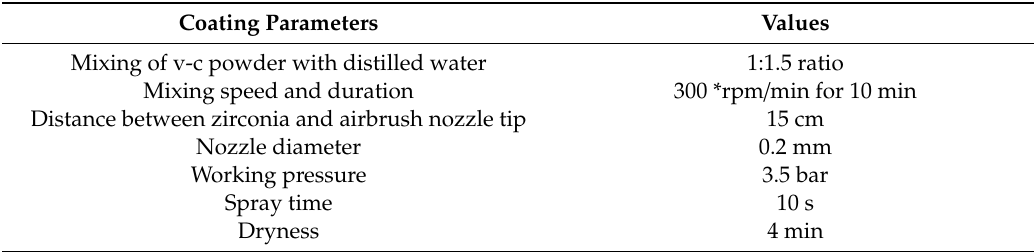
Table 5. Coating parameters for airbrush spraying